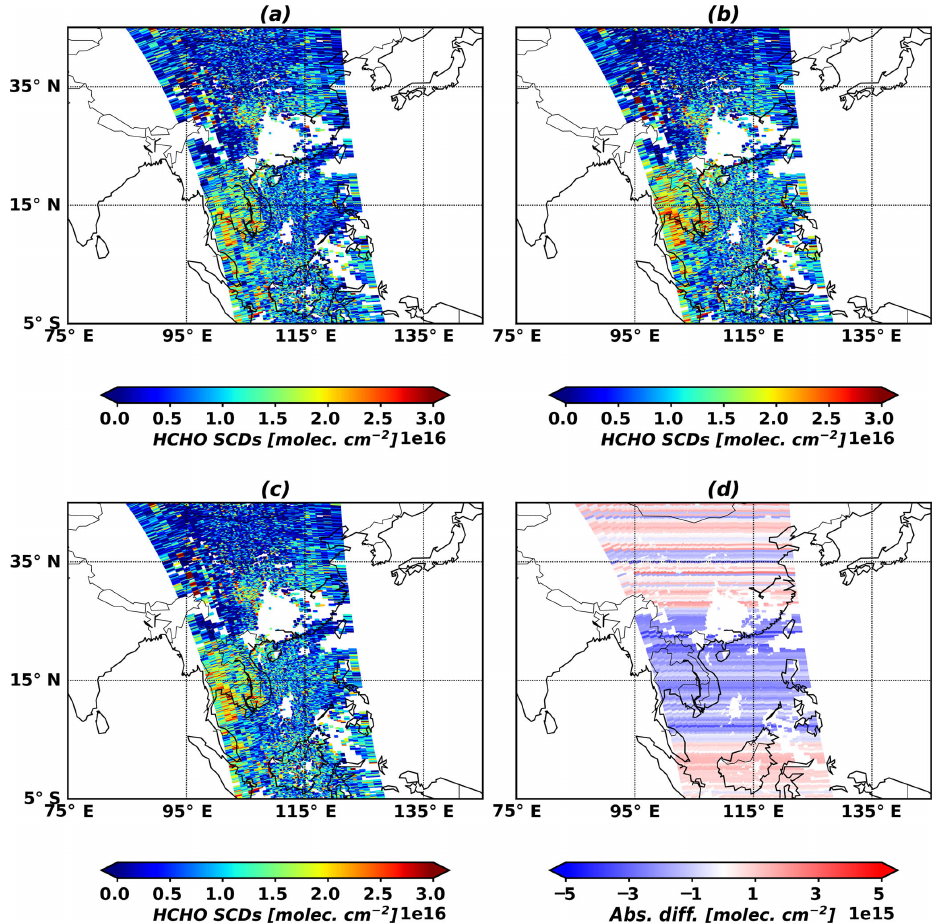
Figure 6. HCHO slant column densities (8 March 2005, orbit 3436): (a) OMHCHO products, (b) the GEMS algorithm without latitudinal bias corrections and (c) GEMS with latitudinal bias corrections, and (d) differences (c–b)